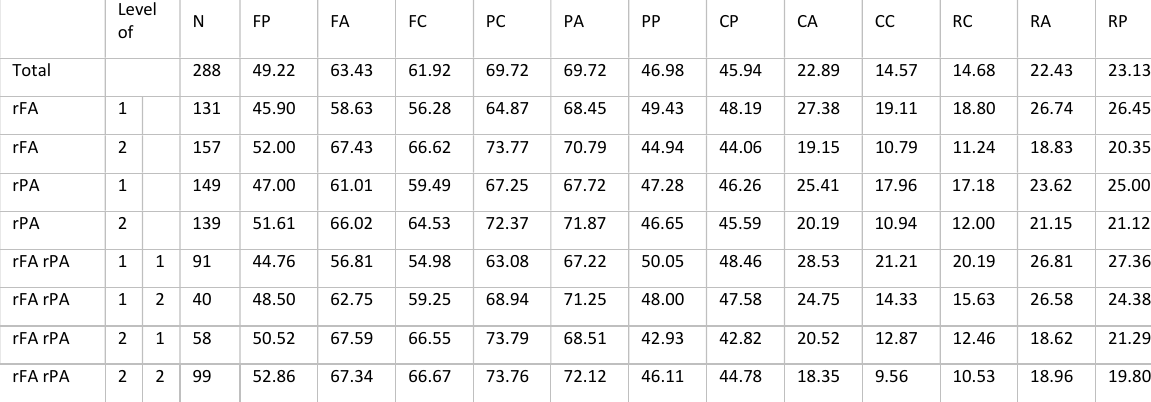
Table 5: Means of the 12 Self ES of clients at post-treatment in the factorial ANOVA by levels of Relational Free Adult ES (rFA) and Relational Protective Adult ES (rPA) of the therapist focused on client (Levels: 1=low; 2=high)